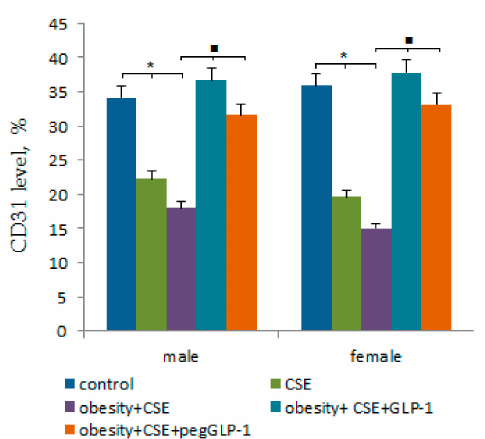
Figure 5. The relative content of cells expressing CD31 antigen in the lungs isolated from male and female C57BL / 6 mice at the immunohistochemical staining for specific cellular marker: CD31 (on the p189). Groups: control—a control group from intact mice, obesity—mice with metabolic disorders (obesity and hyperglycemia), CSE—mice with lungs emphysema, obesity + CSE—mice with metabolic disorders (obesity and hyperglycemia) and lungs emphysema, obesity + CSE + GLP-1—mice with metabolic disorders (obesity and hyperglycemia) and lungs emphysema treated with GLP-1, obesity + CSE + pegGLP-1—mice with metabolic disorders (obesity and hyperglycemia) and lungs emphysema treated with pegGLP-1. * p < 0.05 significance of di ff erence compared with control group, (cid:4) —significance of di ff erence compared with the obesity + CSE group ( p < 0.05). 2.7. Study of Stem Antigens, Epithelial and Endothelial Cells, and Other Cells Using Flow Cytometric